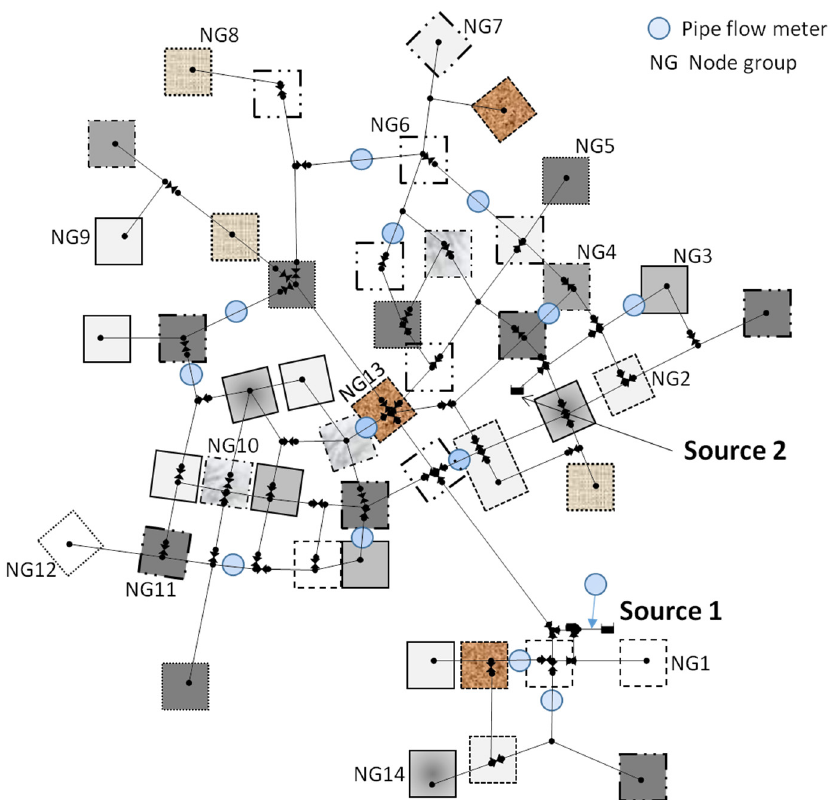
Figure 8. Node groups of a representative initial random solution and meter locations. Each node group is delineated by either a different shape outline or filled by different colors/styles.